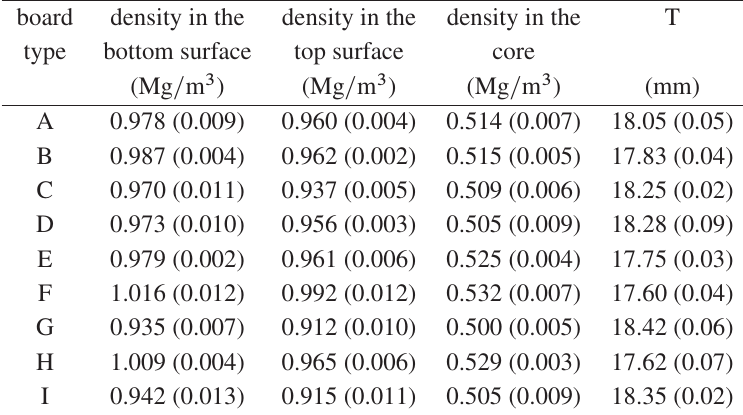
Table 2. The average density profile and thickness values of the test panels.